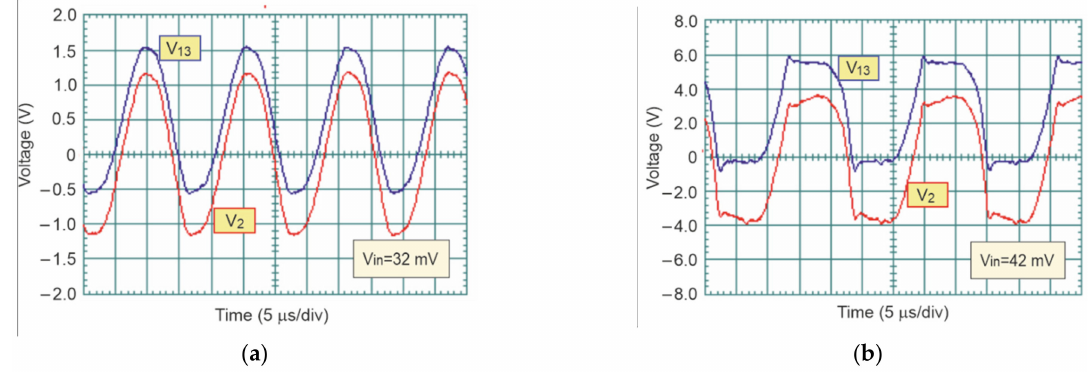
Figure 9. Voltages oscillograms: ( a ) Input voltage is 32 mV; ( b ) Input voltage is 42 mV.